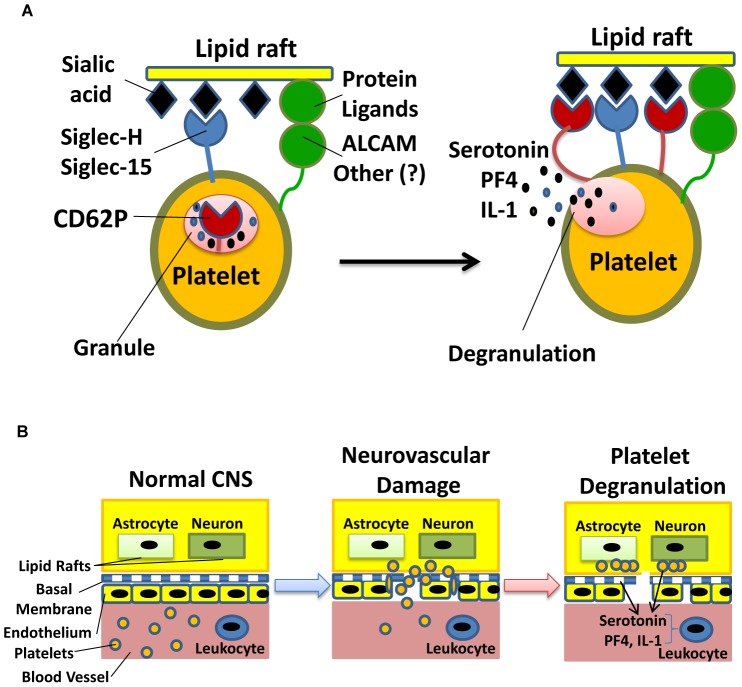
Sialated glycolipids are recognized by platelets as “innate danger signals” of a neuronal damage.(A) The proposed model of brain lipid rafts recognition by the platelet receptors. Multiple receptors on the platelets and an intact rigid structure of brain lipid rafts are required to form glycosynapses for the coordinated platelet activation and degranulation.The initial recognition of brain lipid rafts involves the interplay of siglecs and adhesion molecules such as Siglec-H, Siglec-15, ALCAM or other molecules, which results in the recruitment of P-selectin on the surface of platelets to the site of glycosynapse formation and eventual platelets degranulation. (B) The schematics of the staged neuronal damage detection process by platelets leading to the recognition of lipid rafts during EAE or neurodegenerative diseases such as MS. In the intact CNS, platelets do not see lipid rafts of astrocytes and neurons due to the impermeable nature of the BBB. The trauma, infection, neurodegeneration or inflammation disrupts the structure of neurovascular units, exposing lipid rafts on the surface of astrocytes and neurons to platelets. The platelets then interact with brain lipid rafts, become activated and secrete proinflammatory cytokines (IL-1) and chemokines (CXCL4/PF4) and serotonin that attract immunocytes to the lesion site and activate them in situ. Thus platelets serve as the first line sensors and responders in the early stages of neuronal damage.